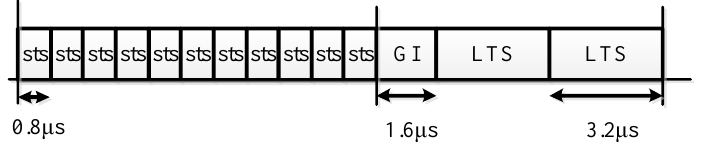
Figure 3. WiFi Preamble Structure.